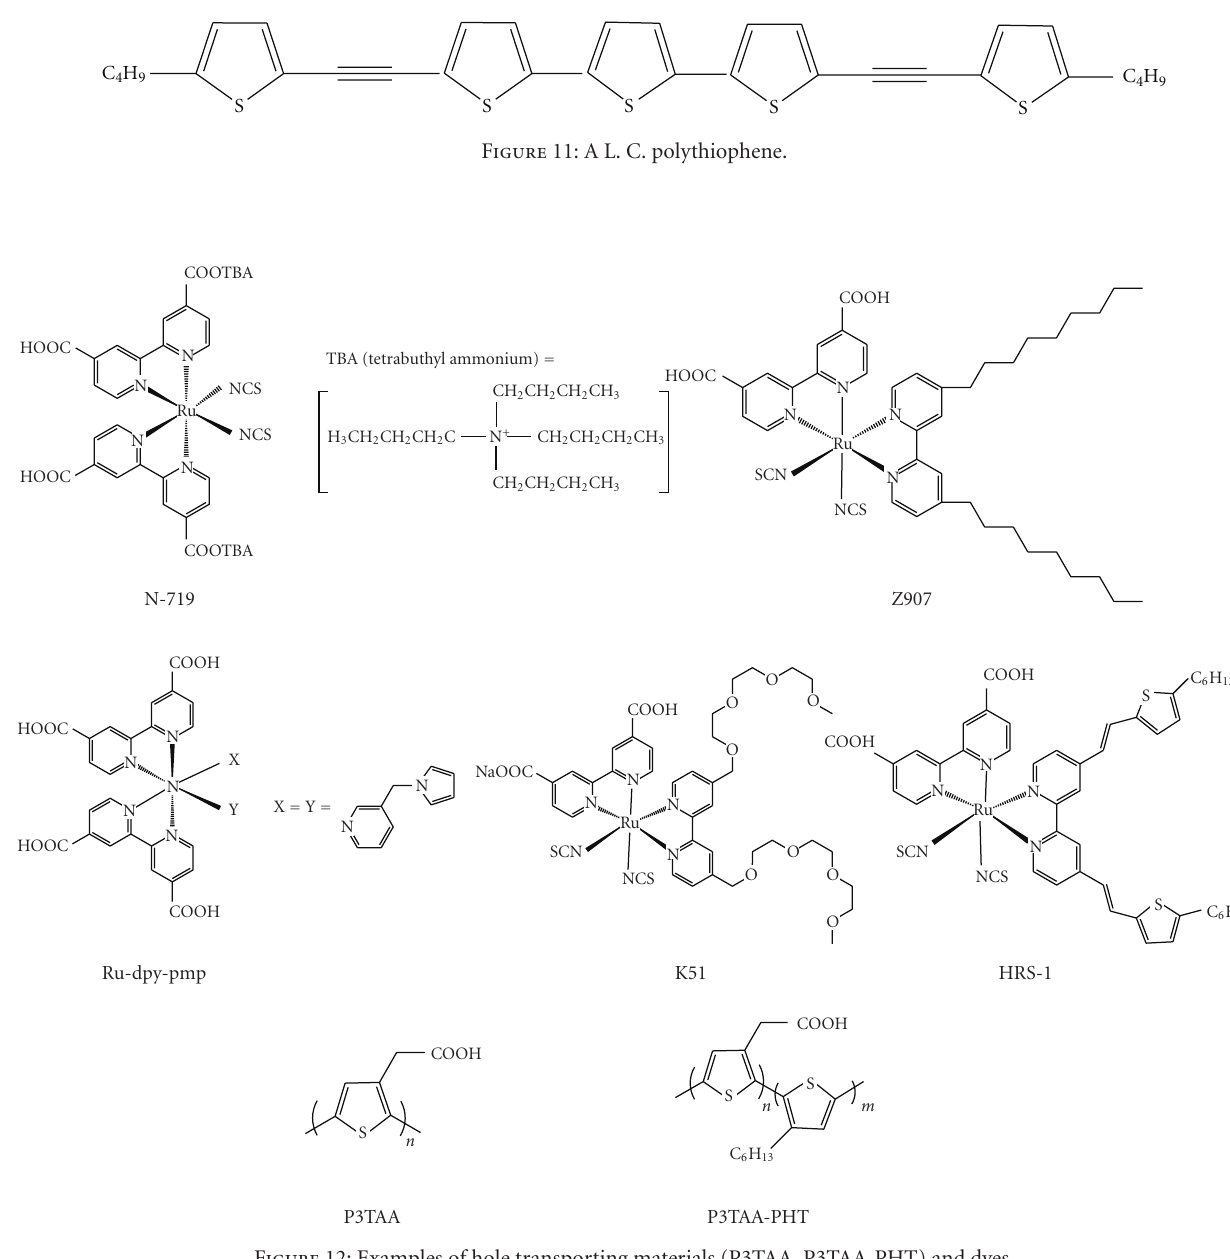
Figure 12: Examples of hole transporting materials (P3TAA, P3TAA-PHT) and dyes.